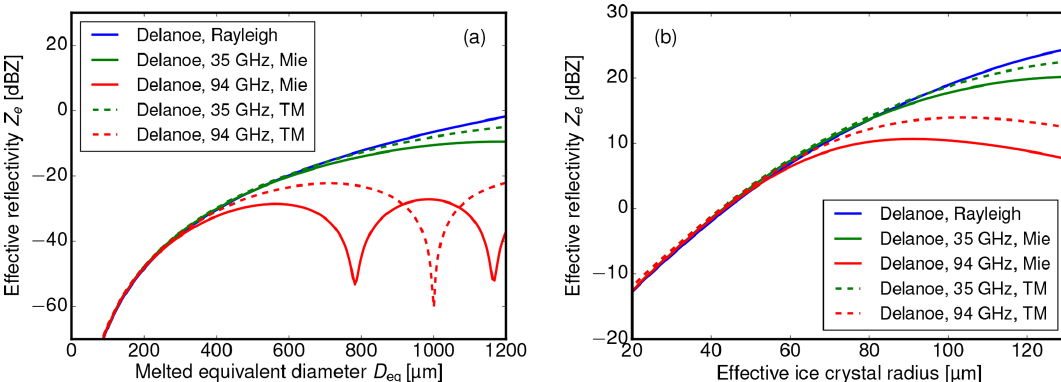
Figure 9. Modeled effective reflectivities at 35GHz (green) and 94GHz (red) as a function of equivalent melted diameter D eq according to Rayleigh (blue), Mie (solid) and T-Matrix (dashed) theory. (a) Results for mono-disperse, horizontally aligned oblate spheroids with an aspect ratio of 0.6, composed of a mixture of air and ice according to Fig. 8. (b) Results for particle size distributions (shown in Fig. 8) of these spheroids with a fixed ice water content of 1gm − 1 .